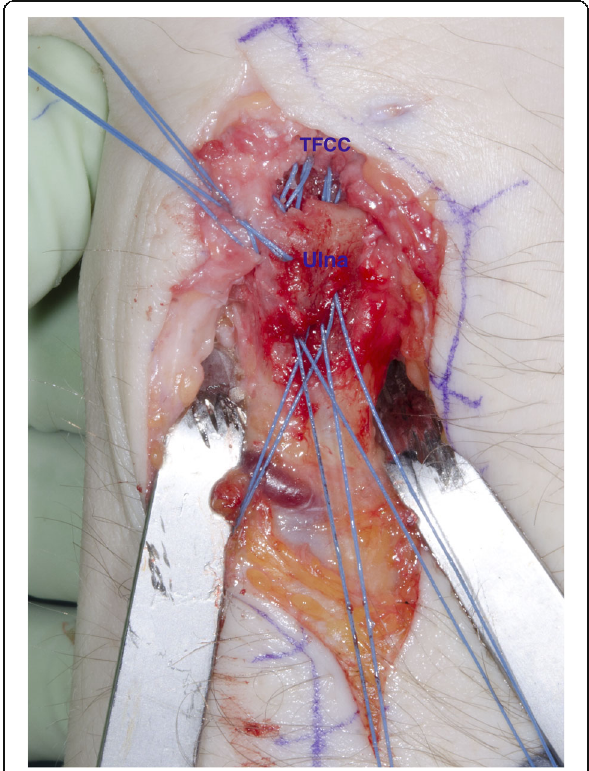
Fig. 2 Open re-insertion of the TFCC with five transosseous sutures (TFCC =triangular fibrocartilage complex, Ulna=distal ulna). Left wrist